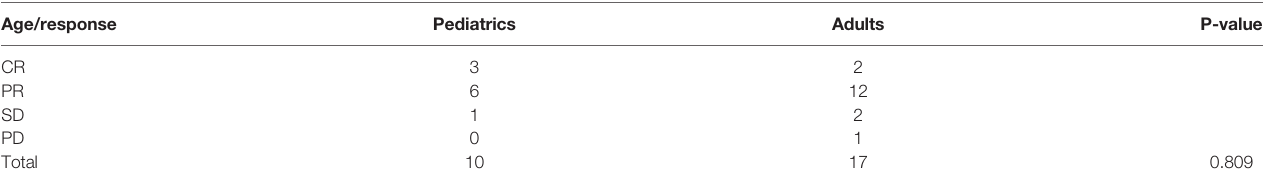
TABLE 2 | Response to crizotinib treatment in pediatric and adult patients. Age/response